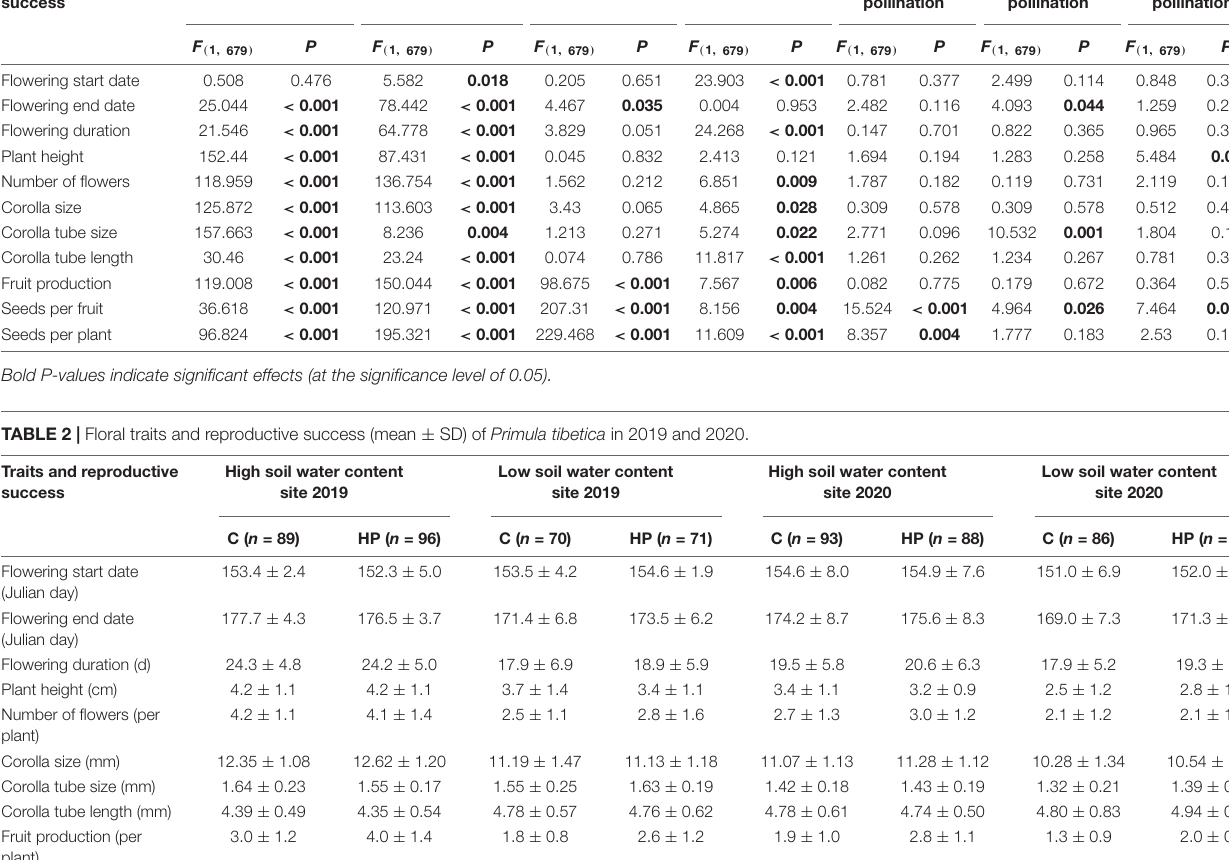
TABLE 1 | ANOVA tests of the effect of year, site, pollination treatment and their interactions on floral traits and reproductive success of Primula tibetica . Traits and reproductive success